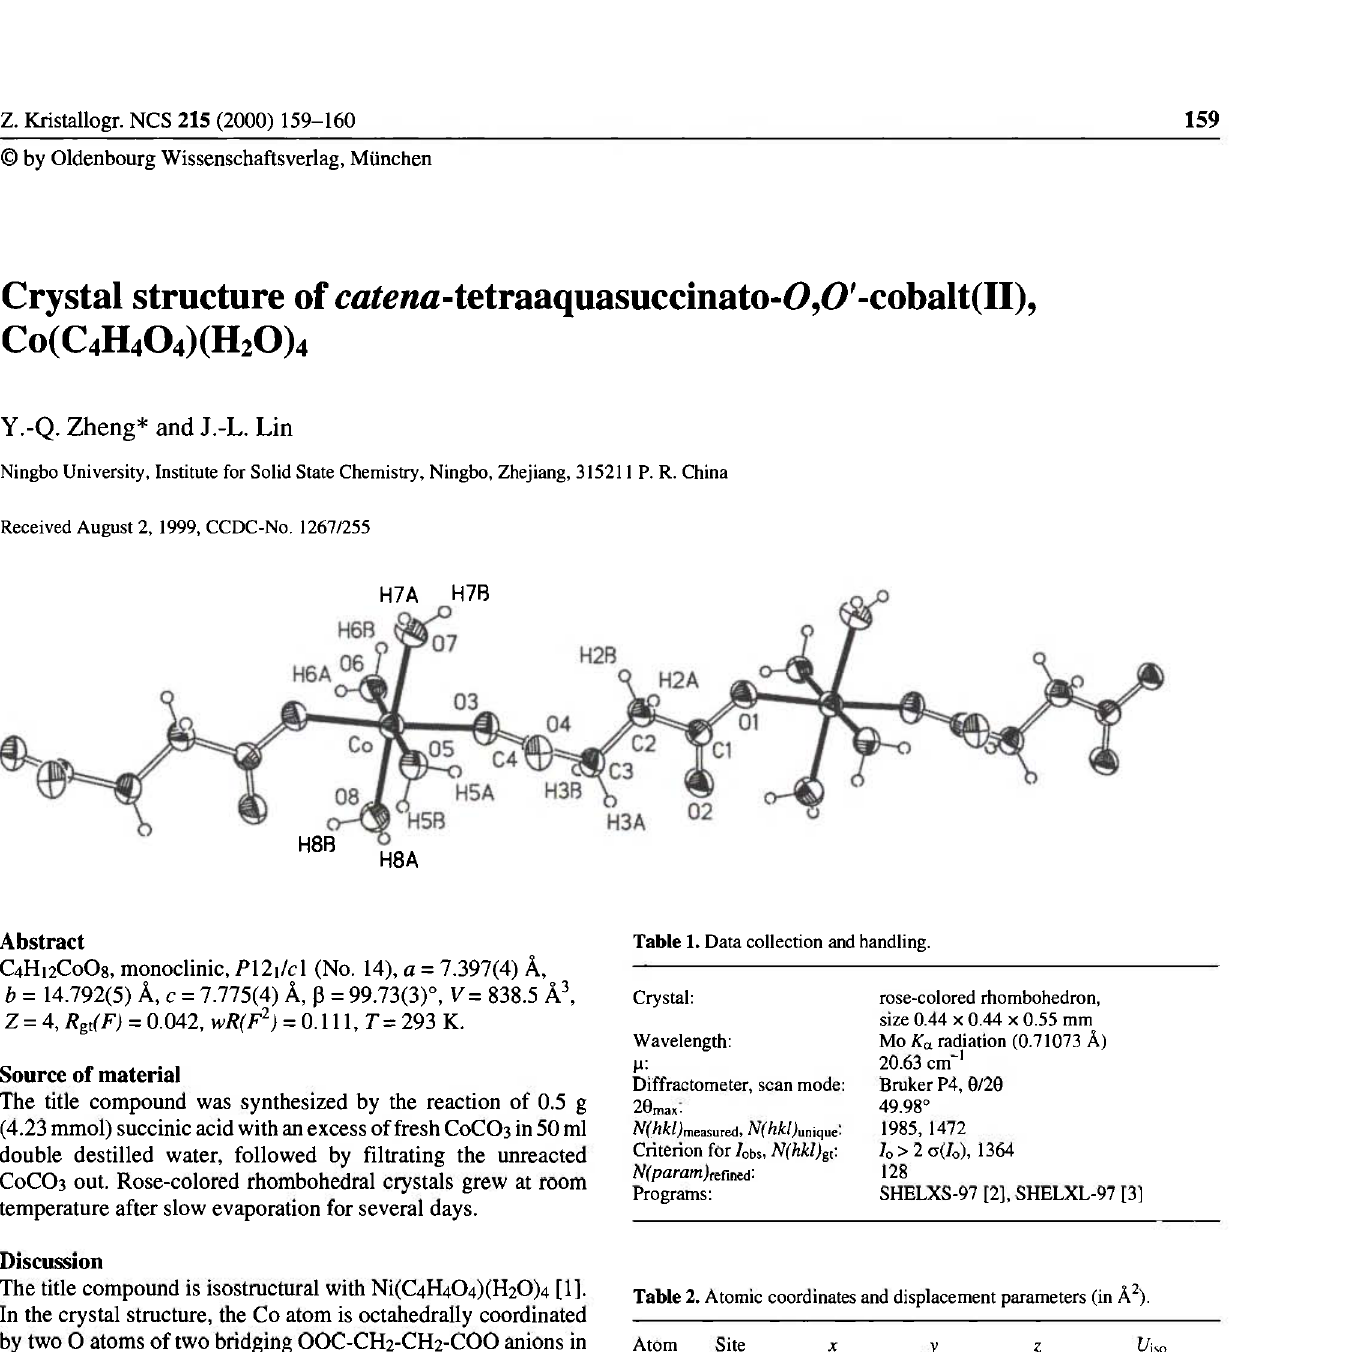
Table 2. Atomic coordinates and displacement parameters (in Ä 2